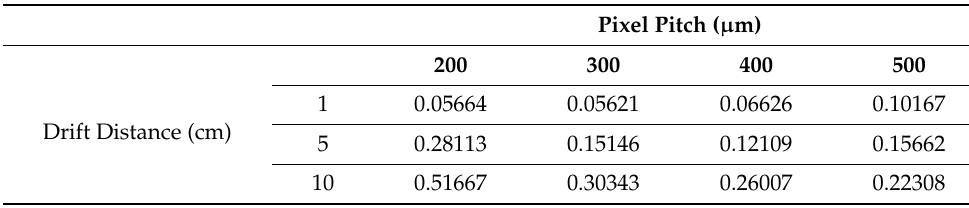
Figure 3. Comparison of the head model predicting accuracy by energy per drift length. Longer drift lengths result in origins that are harder to predict due to the diffusion of charge, and hence loss of information, before readout. Points sizes differ in order to reveal overlapping points. Table 1. Median Euclidean distance error (mm) for the head model across all energies, fixing one of the four pixel pitches and three drift